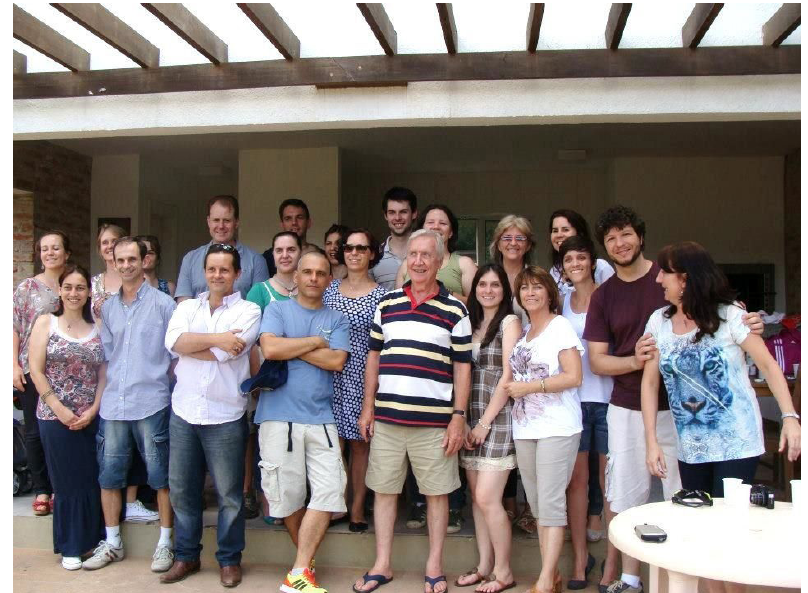
Figure 3. Albano and some of his former students at his home to celebrate his work and retirement, Porto Alegre 2012. (Photo: Fabiana Schneck, personal archives).